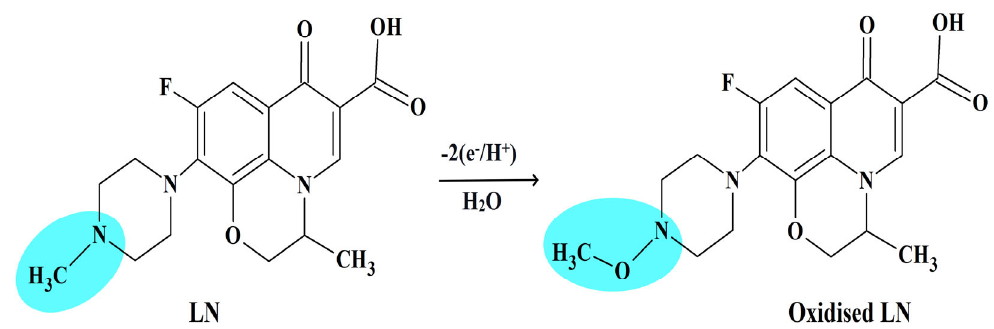
Figure 11. LN reactions [18].